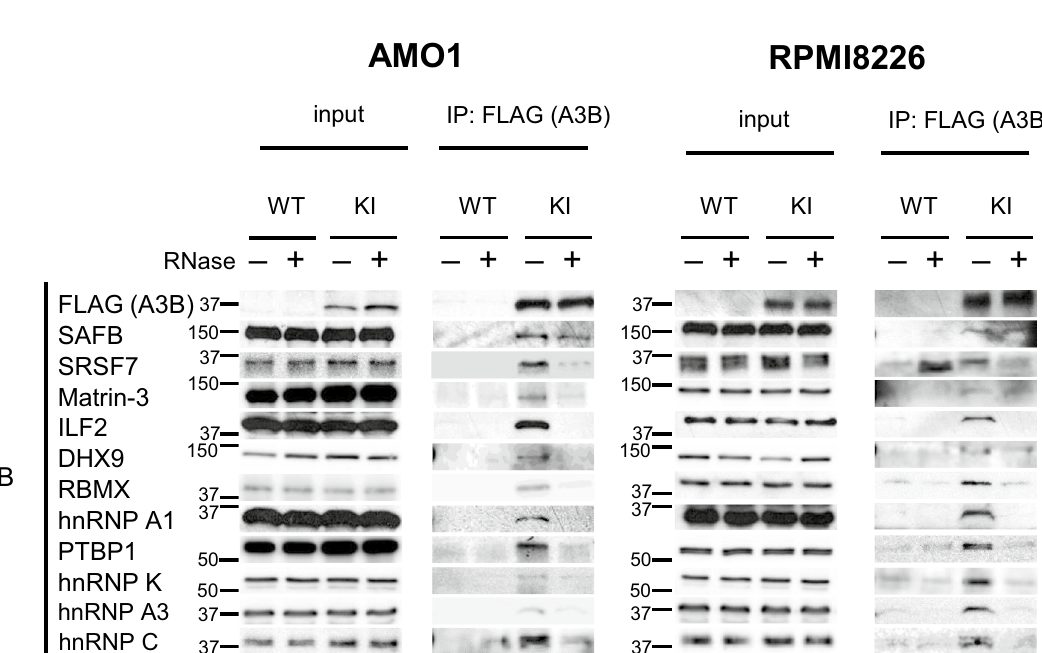
Figure 2. Validation of the interaction with A3B by co immunoprecipitation. Immunoblot analysis of whole cell lysates (3% input) prior to IP and after anti FLAG IP, with or without RNase A treatment ( left , AMO1, right , RPMI8226). All images shown here are representative of three independent experiments. WT , wild type (parental) cell KI , 3 × FLAG IRES EGFP knock in cell lines. Original blots are presented in Supplementary Figure